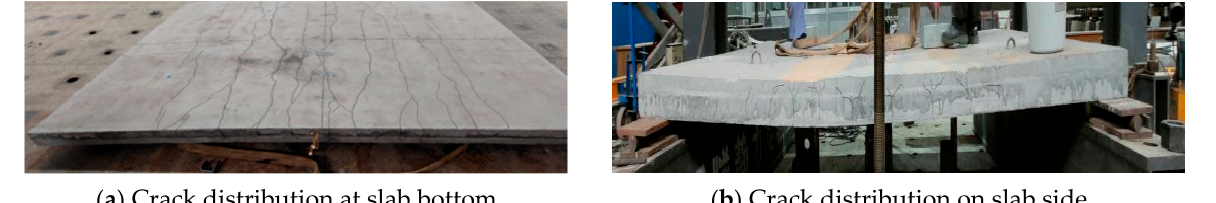
Figure 11. Failure mode and crack distribution of DBD01.